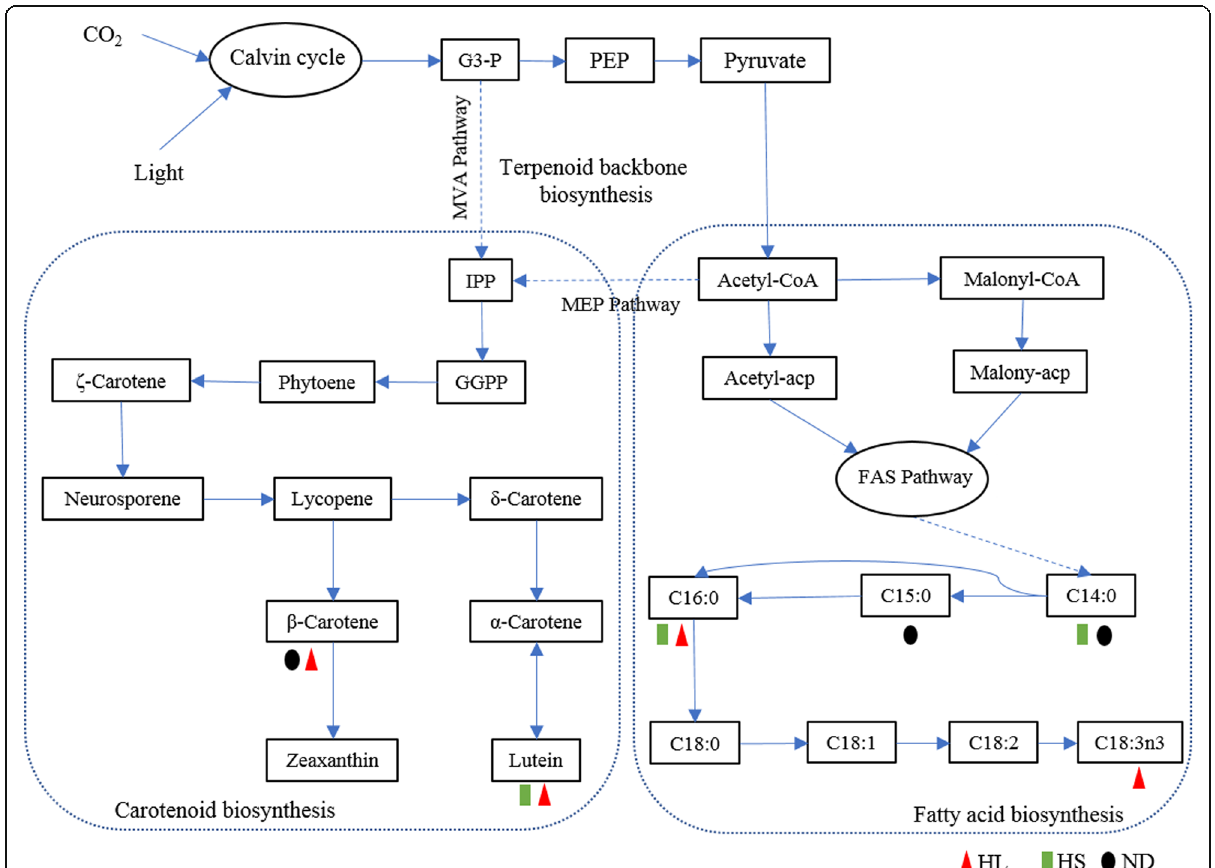
Fig. 6 Schematic diagram of carotenoid and fatty acid metabolism in D. salina Y6. The dotted and solid lines represent indirect and direct chemical reactions, respectively; red triangles, green squares, and black ellipses represent related compounds are increased under the high light (HL), high salt (HS), and nitrogen-depleted (ND) conditions, respectively; G3-P, glyceraldehyde-3-phosphate; PEP, phosphoenolpyruvate; MVA Pathway, mevalonic acid, produced in the mevalonate pathway; MEP pathway, methylerythritol 4-phosphate pathway; IPP, isopentenyl pyrophosphate; GGPP, geranylgeranyl